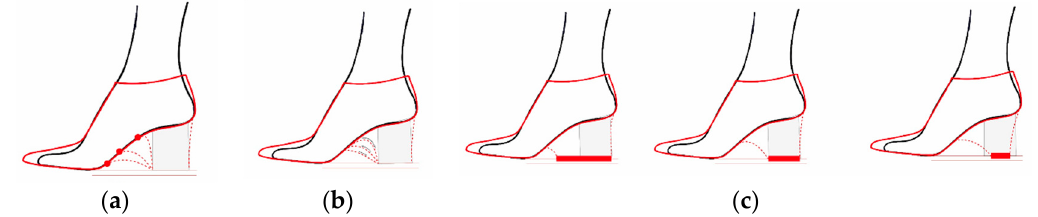
Figure 2. ( a ) Diagram of possible design variations when modifying the starting point of the heel; ( b ) Diagram of the possible design variations when modifying the heel curvature; ( c ) Diagram of possible design variations when modifying the heel support surface.